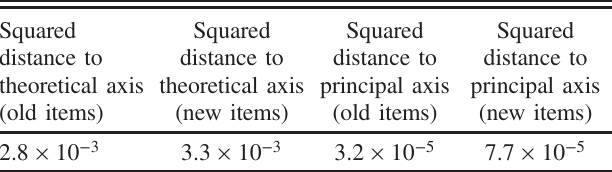
TABLE II. Squared distances between measurement points and principal or theoretical axes.